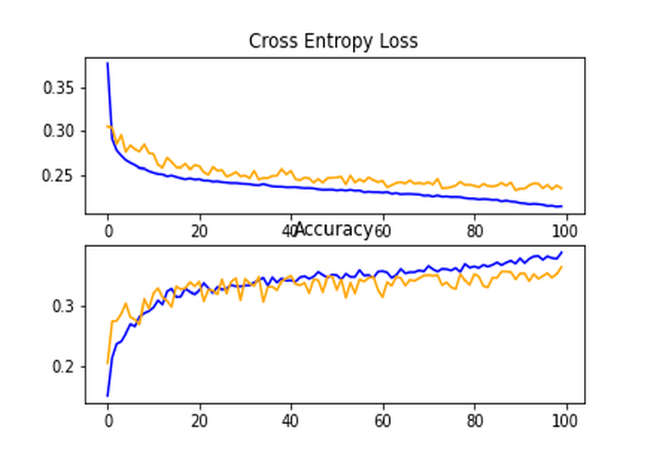
Fig. 5. VGG16 inspired model loss and accuracy